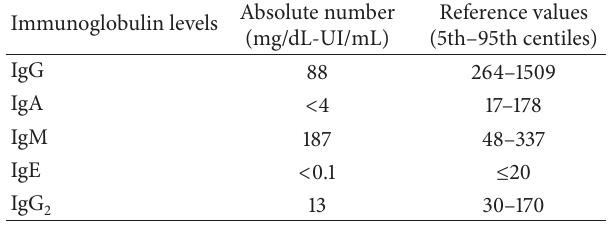
Table 2: Immunoglobulin levels. A reduction of IgG, IgA and IgG subset was found at diagnosis.